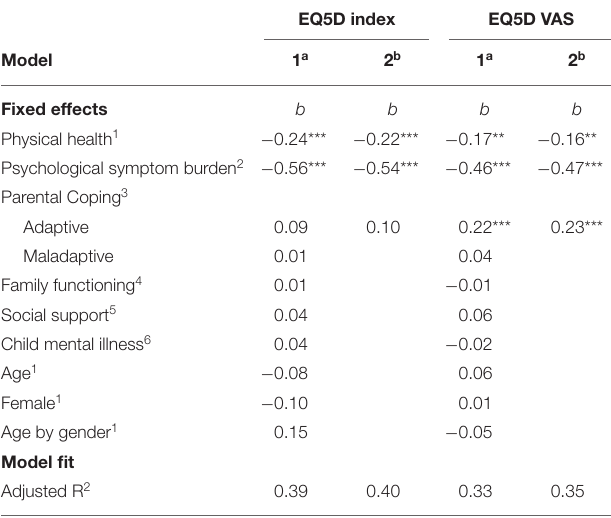
TABLE 3 | Risk and protective factors associated with global HRQoL in parents with mental